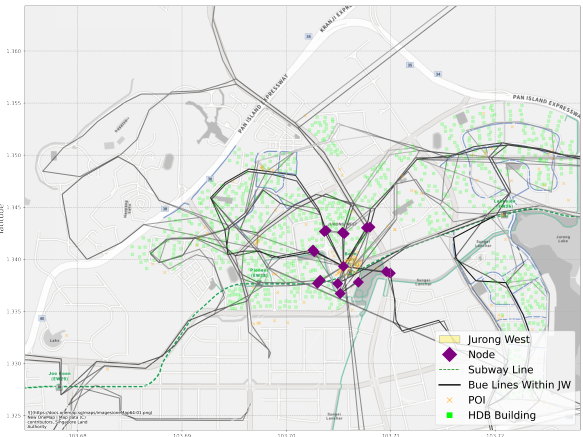
Figure 7. The distribution of HDB buildings, POIs, bus and subway lines and existing nodes that contain more than 10 stores in the Jurong West planning area.